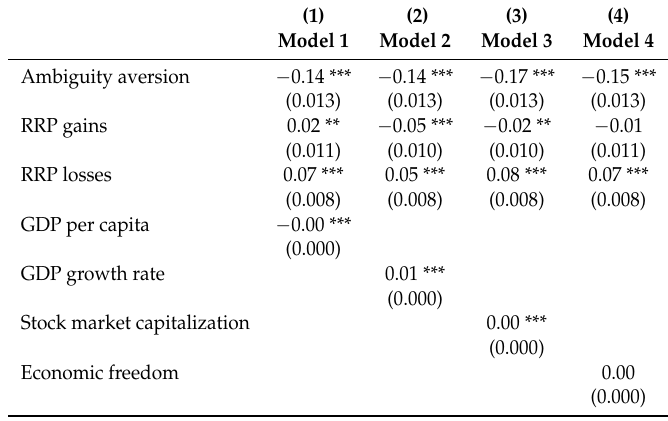
Table 11. Down-weighting outliers for the equity premia, ambiguity aversion and risk